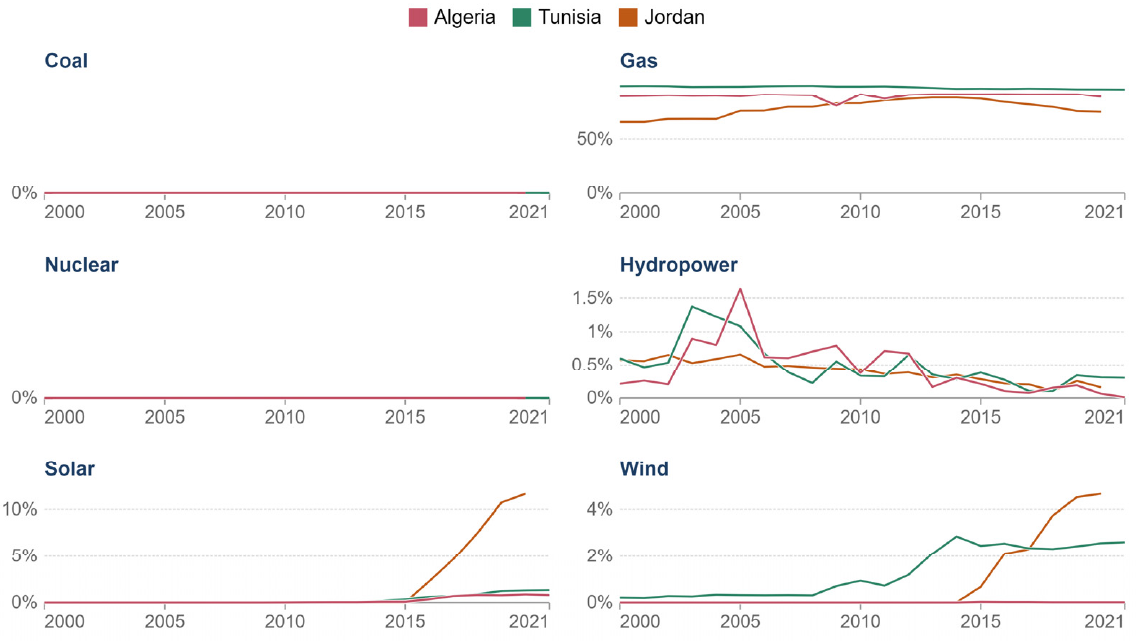
Figure 2. Share of electricity production by source for Tunisia, Algeria and Jordan. Source: Our World in Data based on BP Statistical Review of World Energy. OurWorldInData.org/energy, CC BY.